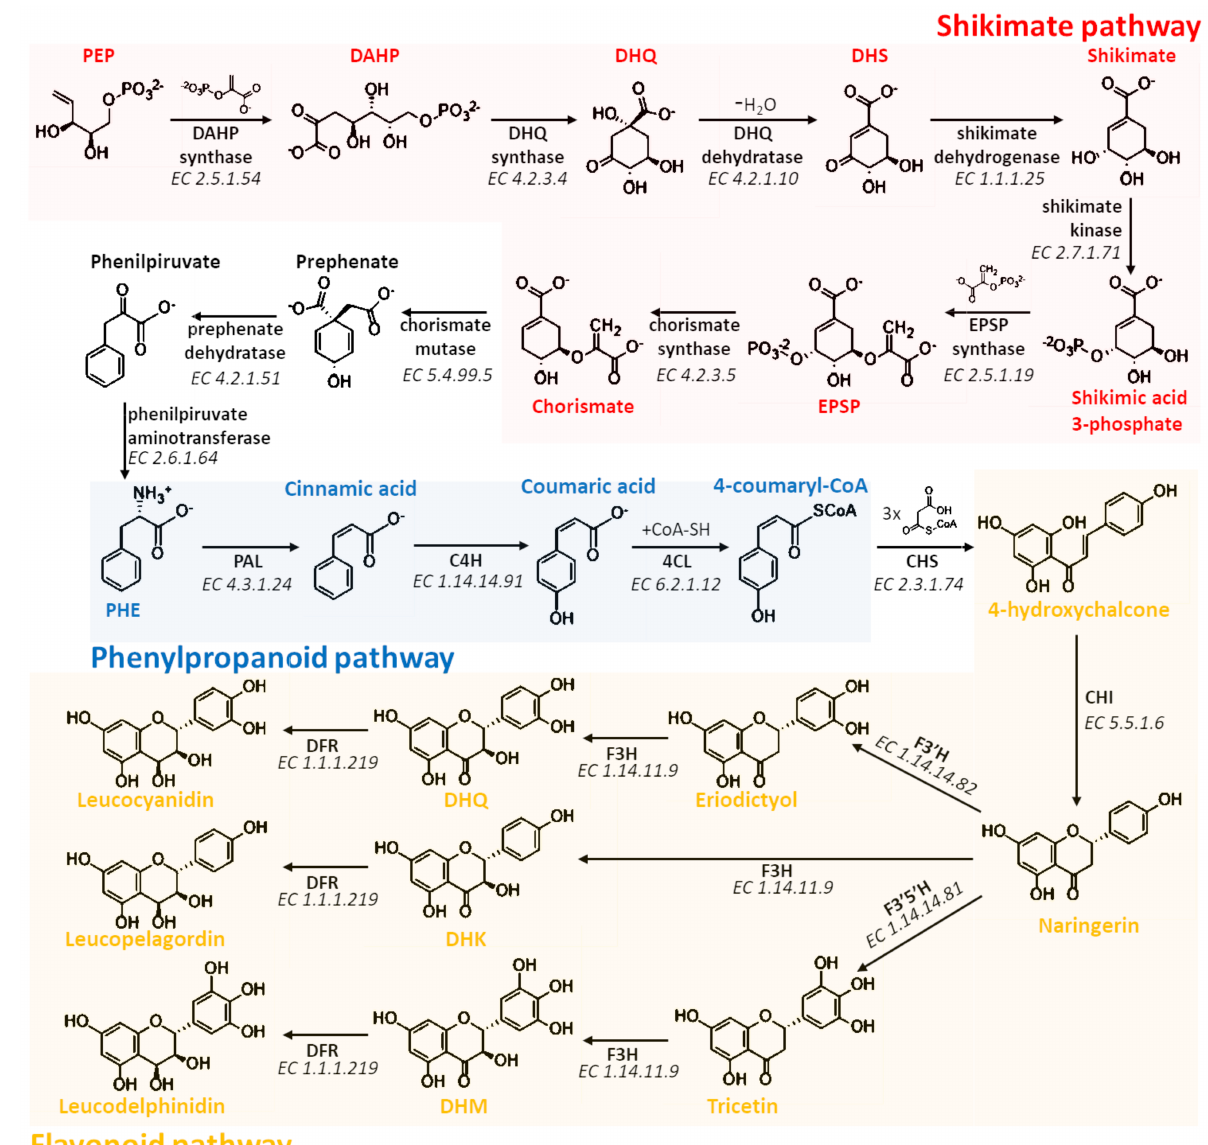
Figure 5. Biosynthetic pathway involved in the synthesis of leucoanthocyanidins, the key precursor compounds of flavan-3-ols. The pathway involves the shikimate (Red), phenylpropanoid (Blue), and flavonoid (Yellow)